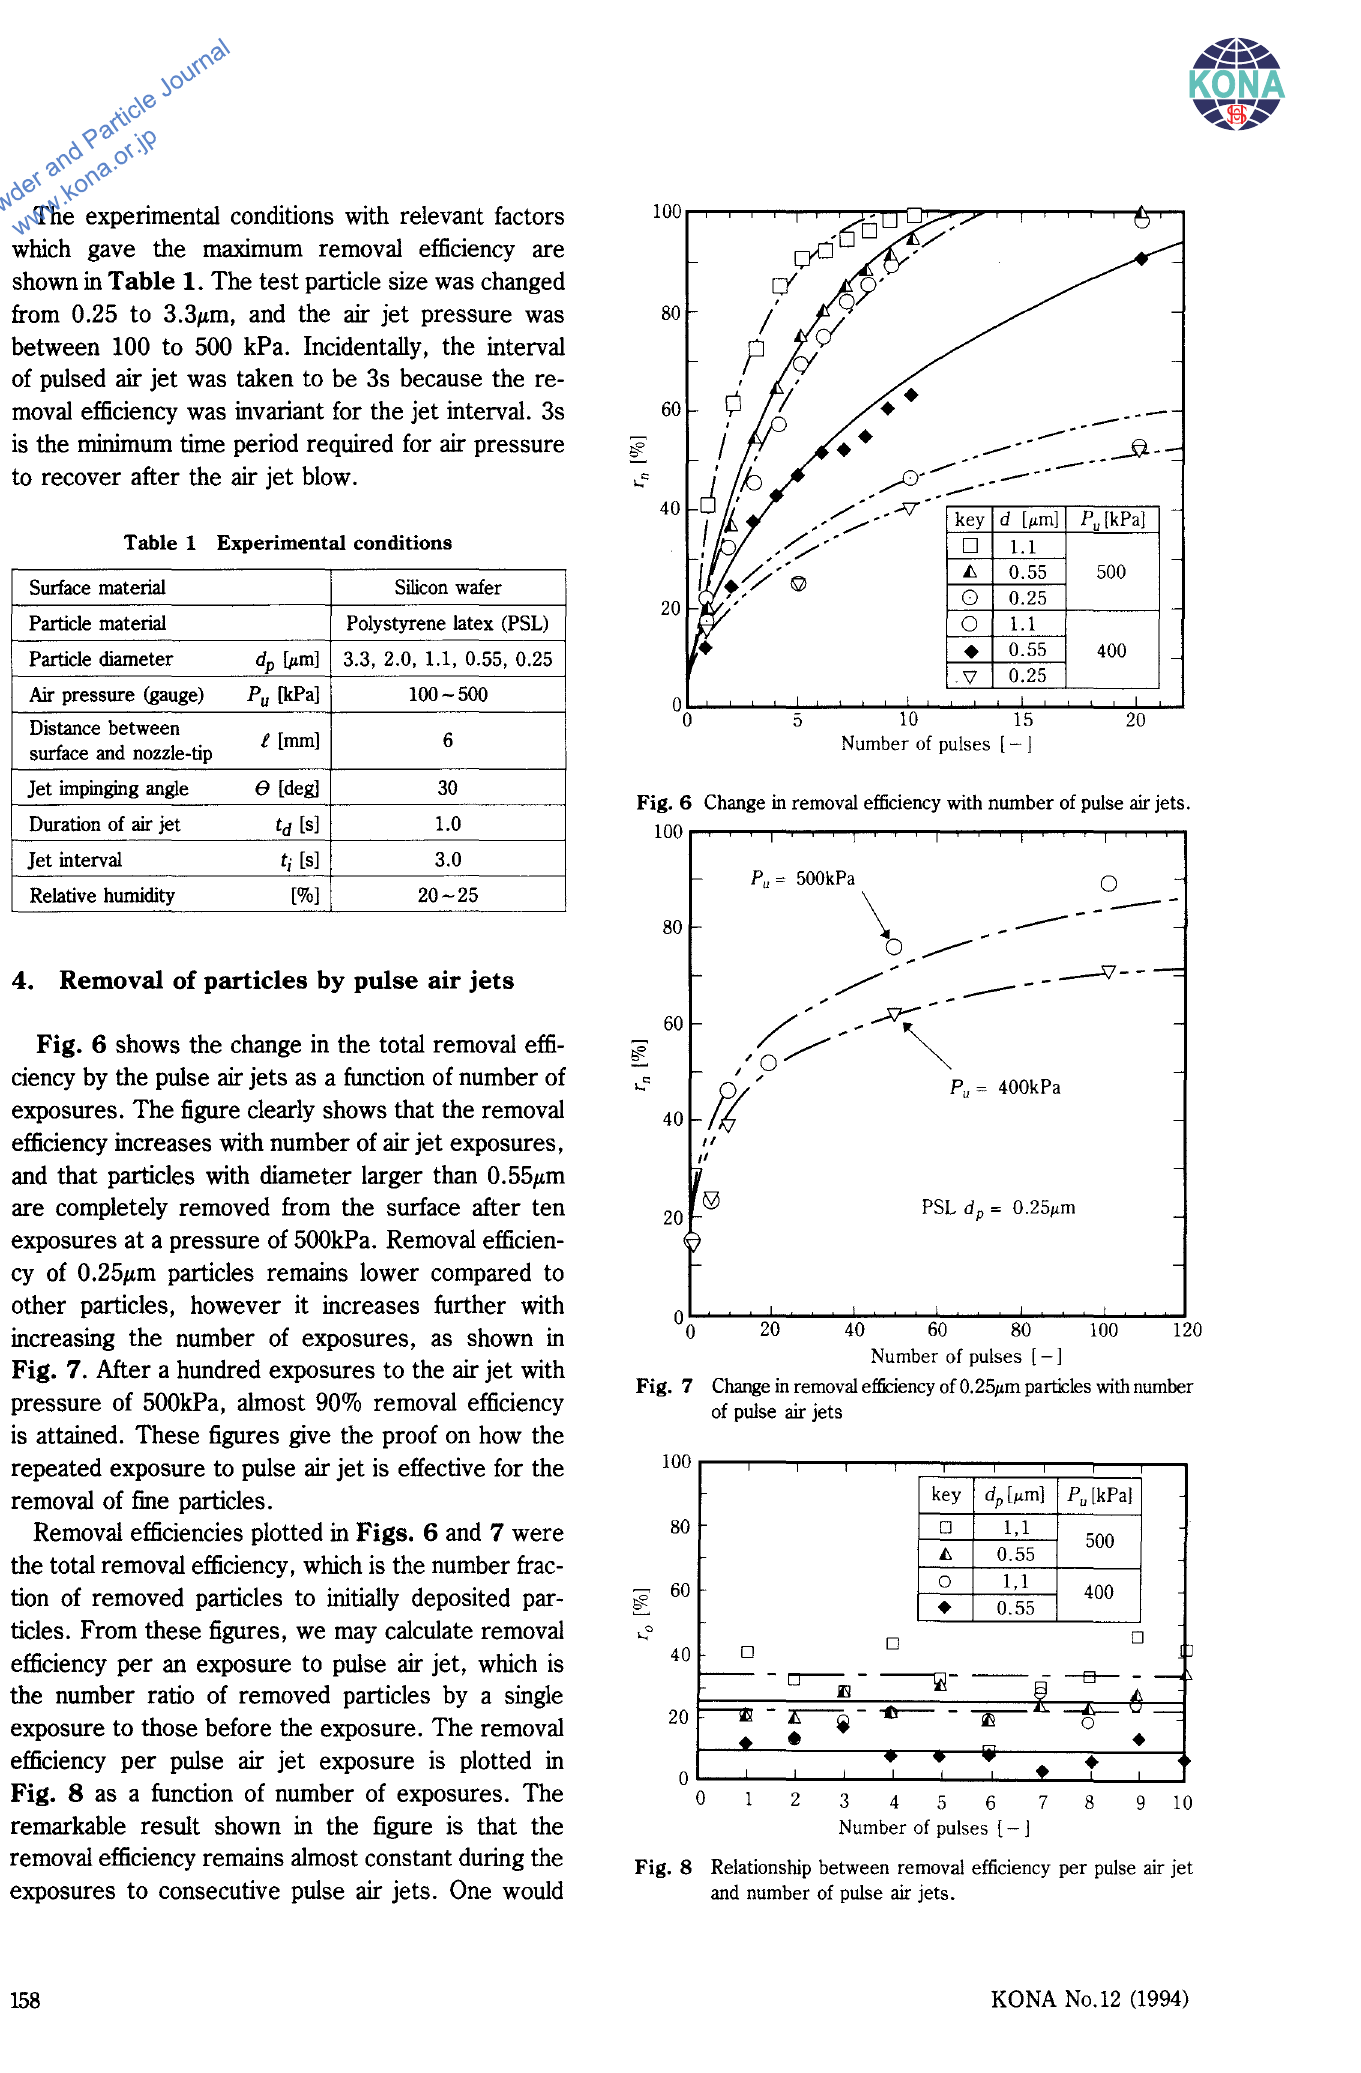
Fig. 8 Relationship between removal efficiency per pulse air jet and number of pulse air